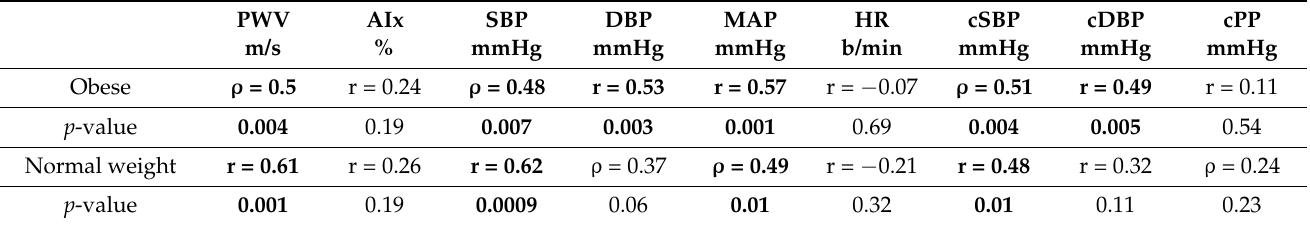
Table 13. Correlations between waist circumference and PWA parameters in obese and N-weight subjects (Pearson’s r and Spearman’s ρ